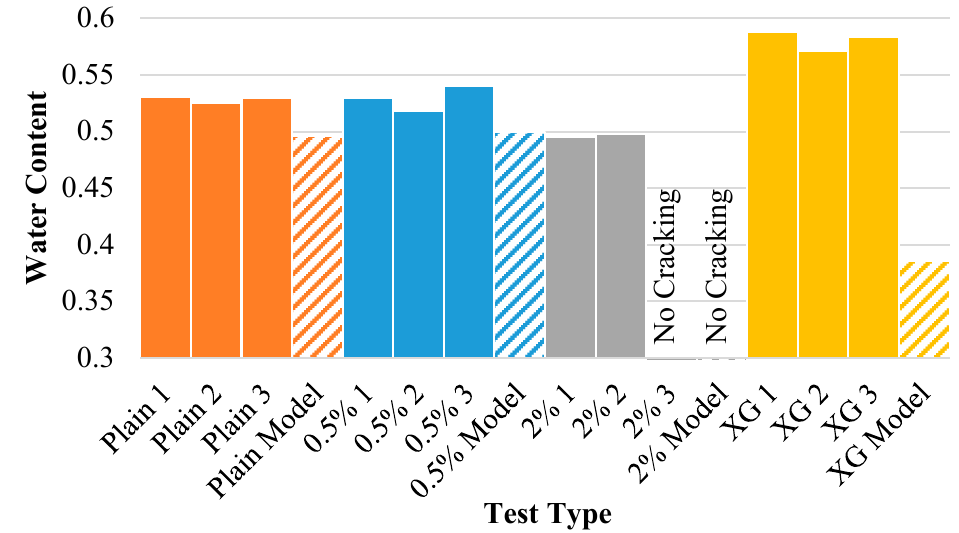
Figure 17. Internal crack water content for each of the experiments and model results.